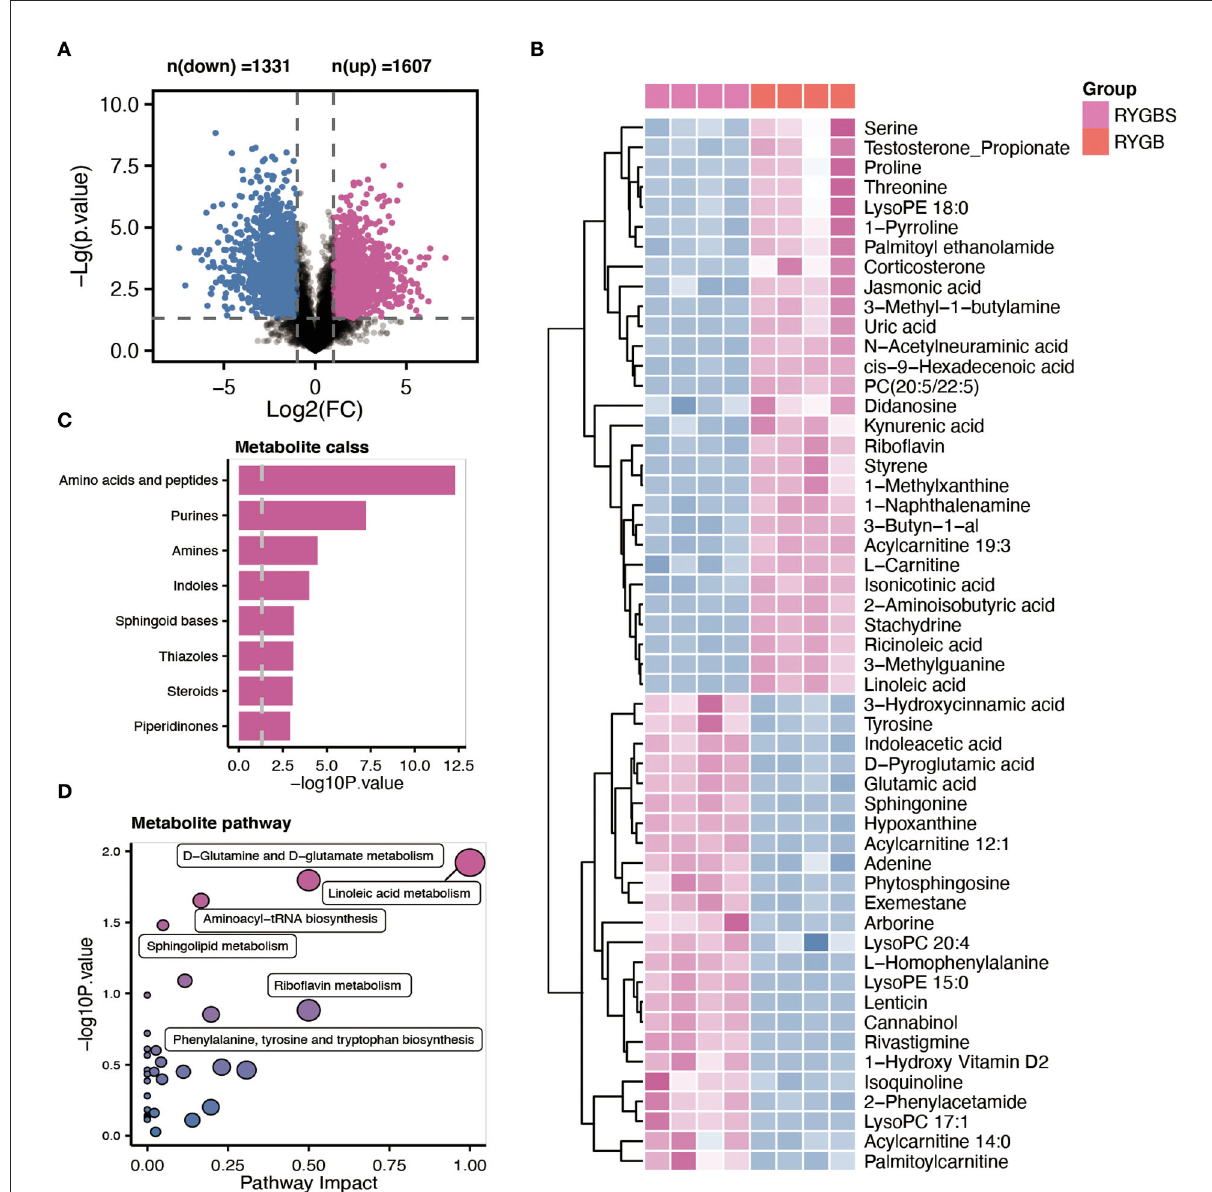
FIGURE4 Comparative metabolomic analysis determines the change in plasma metabolites in RYGB rats from the sham operation. (A) The volcano plot shows the number of dysregulated metabolite features between the two groups. (B) The heatmap shows the annotated metabolites based on the KEGG database in the plasma profile. (C) Metabolic set enrichment analysis of different metabolites. (D) The KEGG pathway analysis based on the different